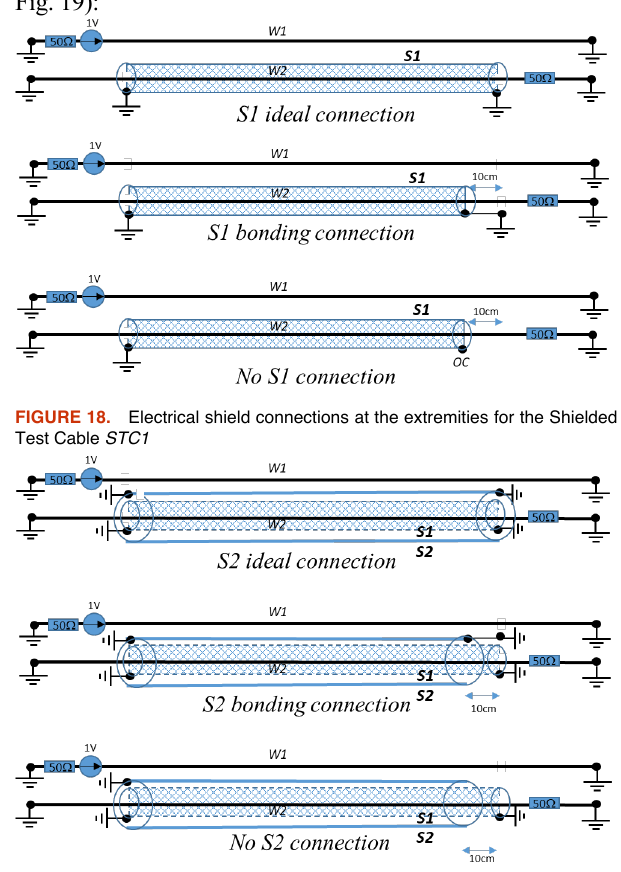
FIGURE 19. Electrical shield connections at the extremities for the Shielded Test Cable